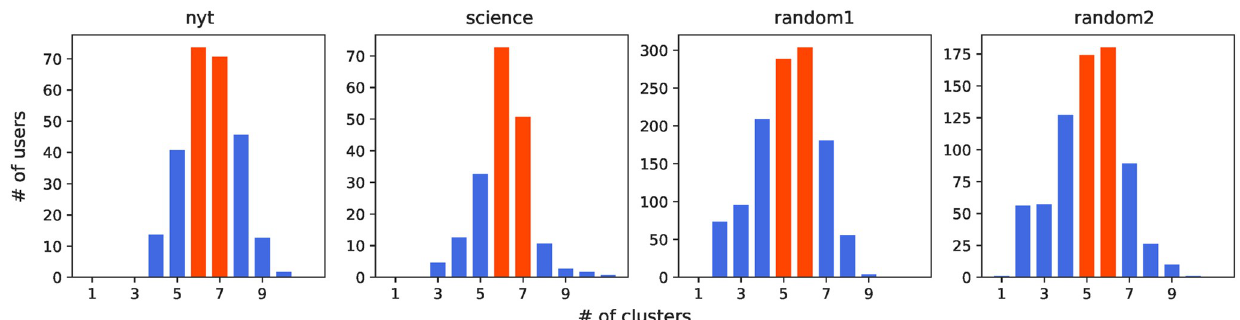
Fig 4. Optimal number of clusters. The clusters are obtained by applying Mean Shift to log-transformed frequencies. The most frequent number of clusters is highlighted in red.